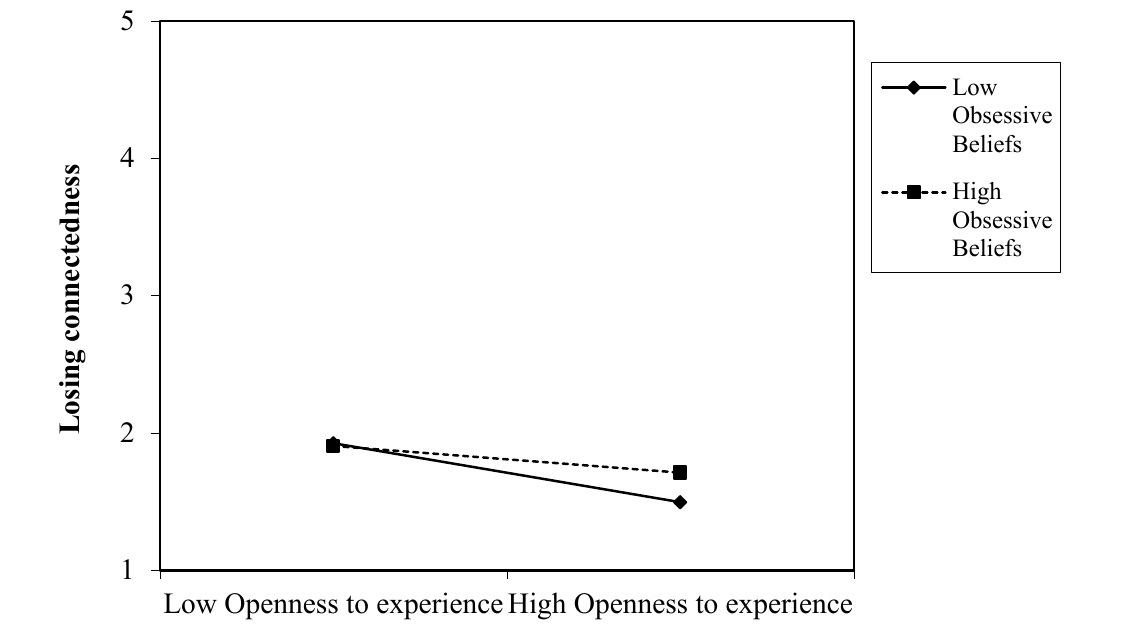
Figure 4. Interaction of openness to experience and obsessive beliefs in predicting the fear of losing connectedness.